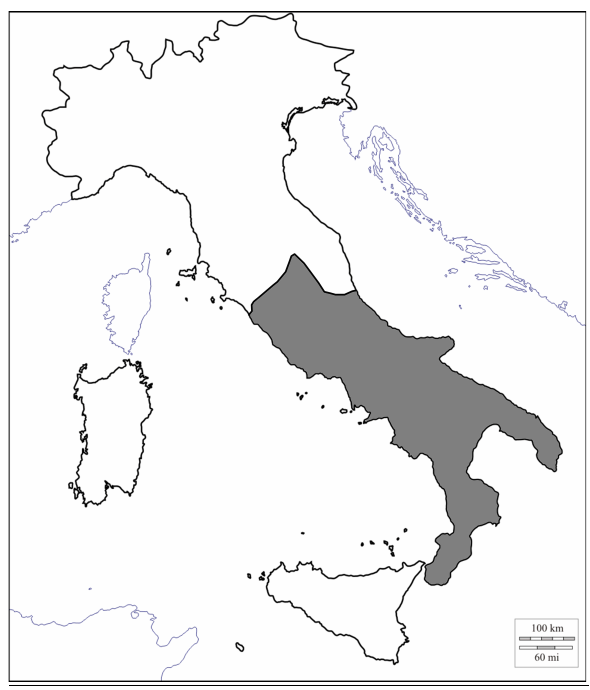
Figure 7. Distribution map of Talpa romana (redrawn from Loy 2008)